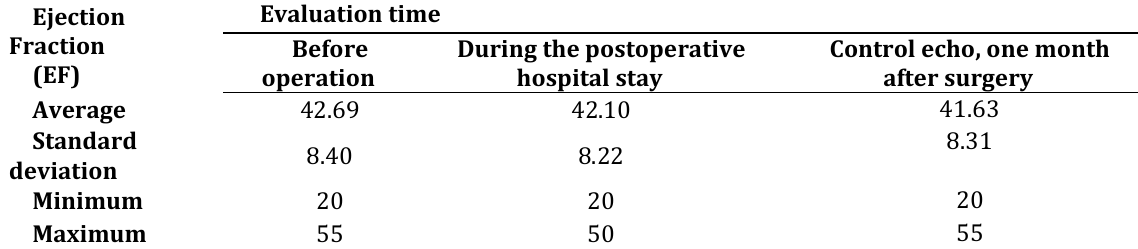
Table 2: Frequency distribution of ejection fraction (EF) in patients